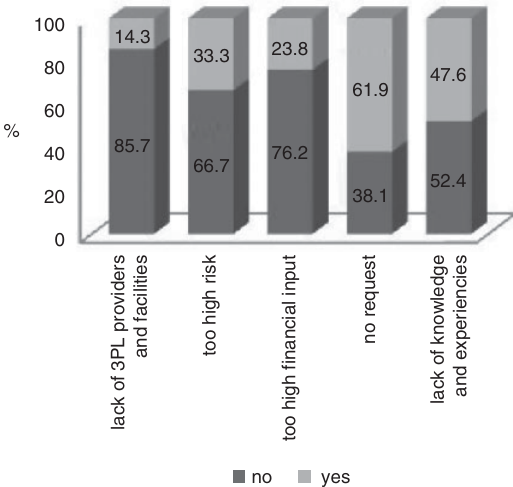
Fig. 2. Reasons for inability to offer 4PL